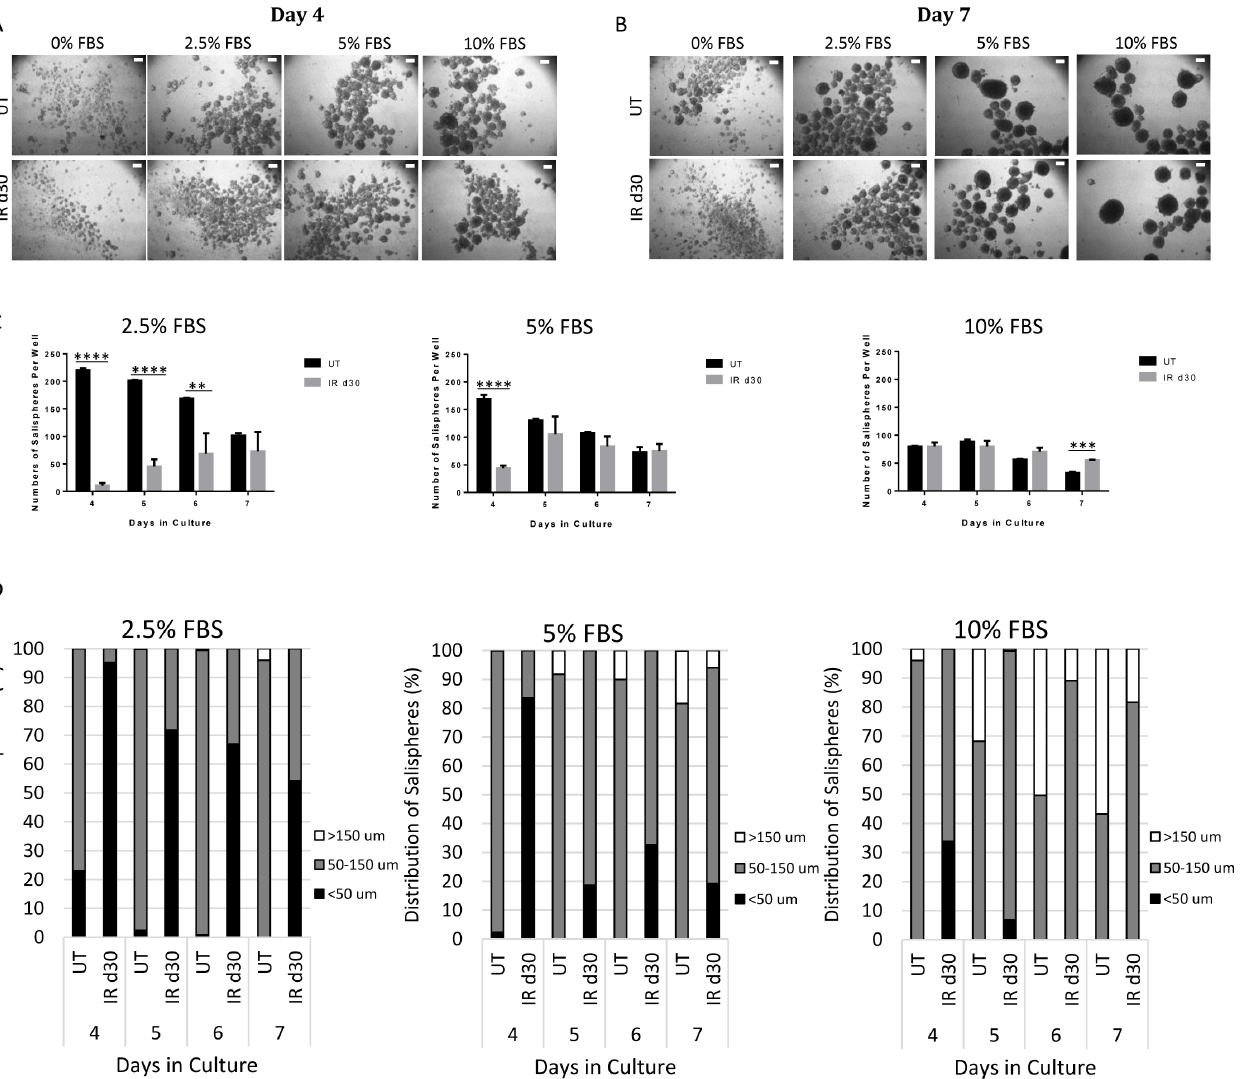
Fig 3. FBS increases sphere-forming efficiency of irradiated parotid-derived cells. Representative bright field images of salispheres grown from UT (untreated) and IR d30 (irradiated) glands in serum-free media, supplemented with different concentrations of fetal bovine serum (FBS), taken at day 4 (A) and 7 (B) in culture. Number of salispheres was quantified per 6 wells from 3 primary cell preparations per treatment group at days 4–7 in culture and expressed as average ± SEM. P values were obtained with a 2-sided unpaired t-test (n = 3), (cid:3)(cid:3) p < .01, (cid:3)(cid:3)(cid:3) p < .001, (cid:3)(cid:3)(cid:3)(cid:3) p < .0001 (C). Representative graphs showing the distribution of salisphere sizes among all the salispheres counted from one UT and IR d30 primary sphere preparation (D). Scale bar = 100μm.